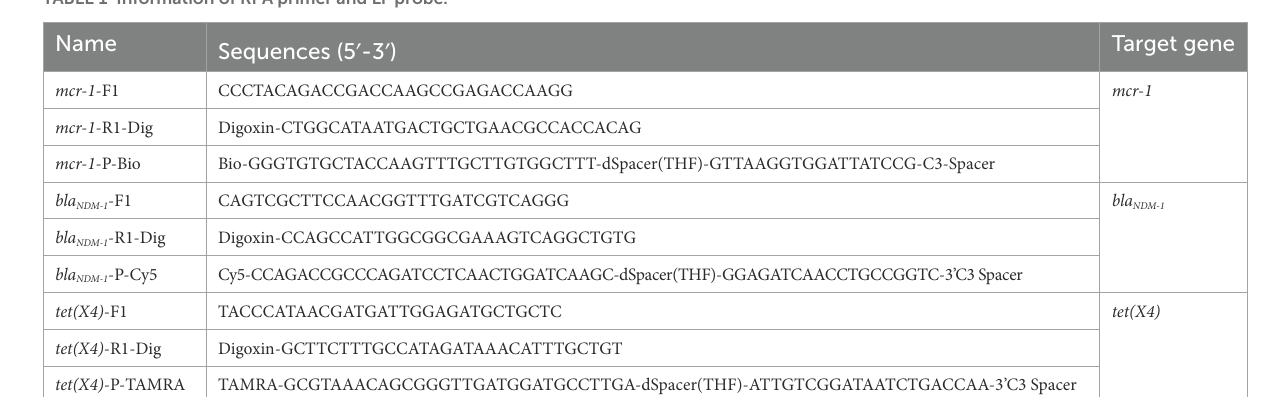
TABLE 1 Information of RPA primer and LF